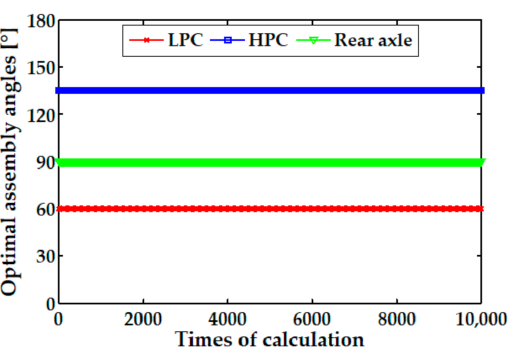
Figure 12. The optimal solution of the dual objective optimization in the 10,000 times